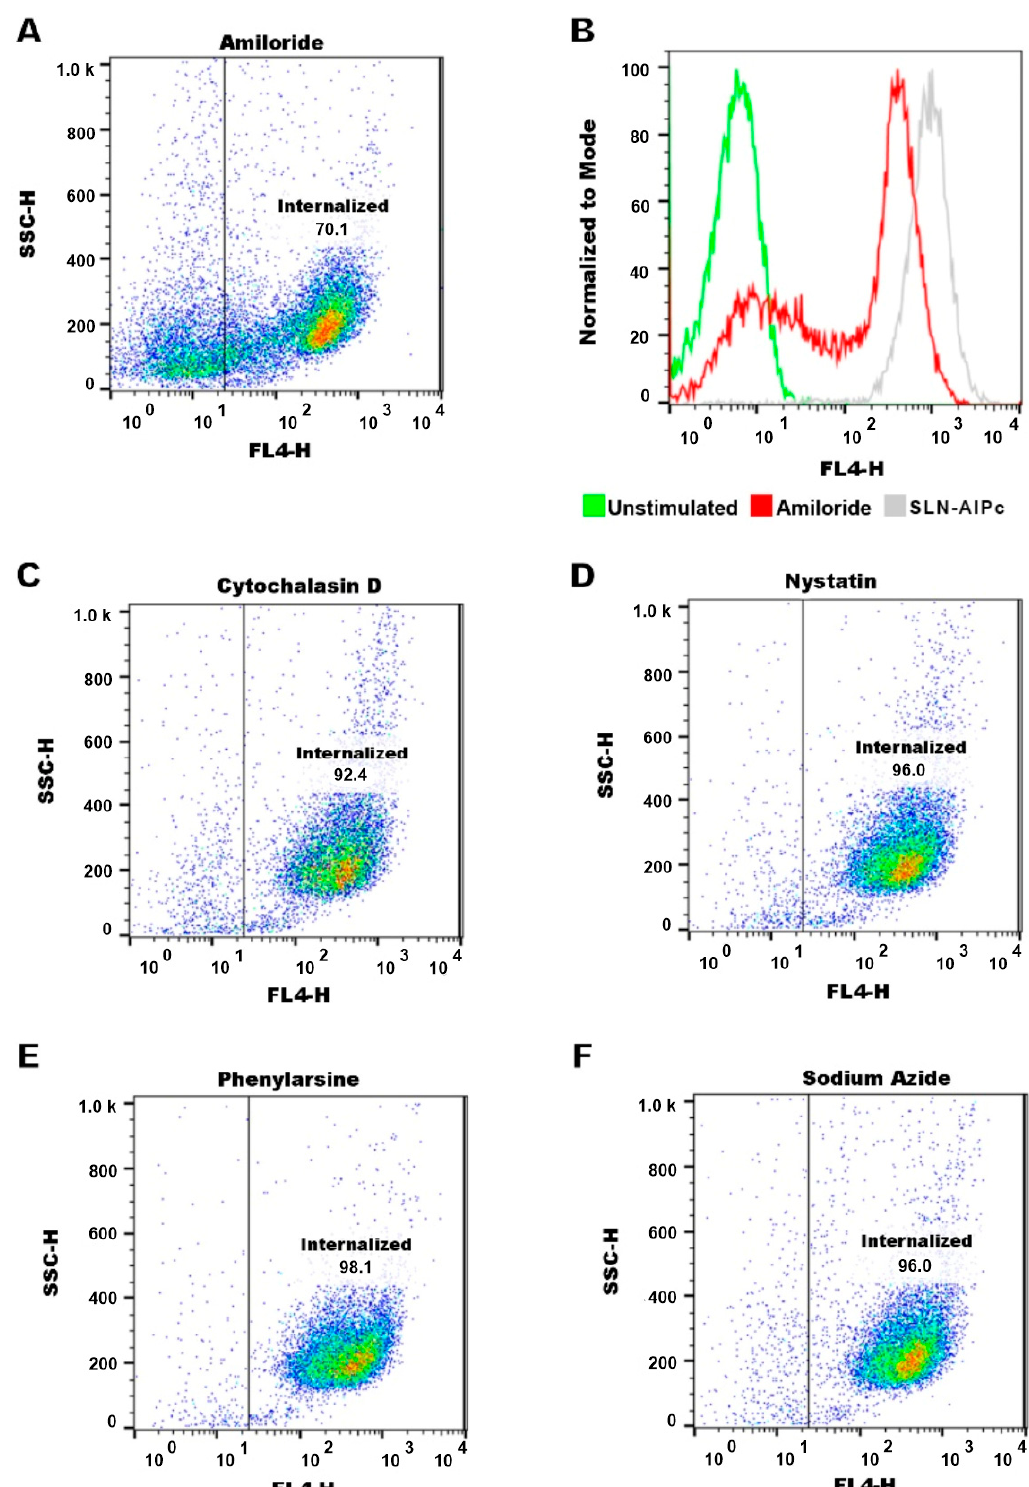
Figure 10. Endocytosis pathway characterization using different endocytosis inhibitors: ( A ) a reduc- tion in the fluorescence signal of SLN-AlPc was observed when treated with amiloride, indicating a decrease in SLN-AlPc internalization by the macropinocytosis pathway; ( B ) histogram of the fluo- rescence signal in B16-F10 cells treated with amiloride and SLN-AlPc. The cytochalasin D ( C ), nys- tatin ( D ), phenylarsin ( E ), and sodium azide ( F ) did not alter the fluorescence signal of SLN-AlPc.